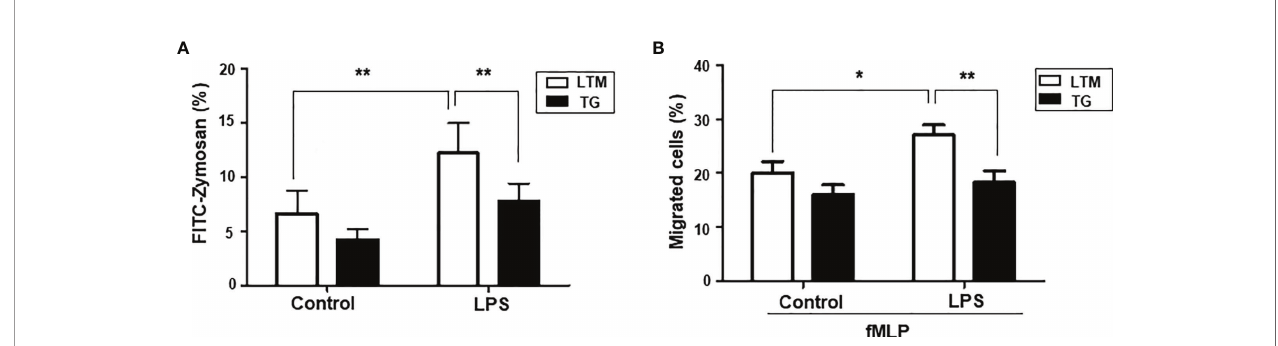
FIGURE 5 | Phagocytic and chemotactic ability of PMs from LTM and p190RhoGEF TG mice. PMs from LTM and TG mice were cultured in media with or without LPS (100 ng/ml) overnight. These PMs were used for the assay. (A) PMs (2.5 x 10 5 ) were incubated with FITC-conjugated zymosan (20 m g/ml) at 37 ° C for 30 minutes. The PM population made fl uorescent by zymosan internalization was detected using fl ow cytometry. The data are the mean ± SEM of fi ve independent experiments. Statistical signi fi cance was analyzed by one-way ANOVA with Tukey ’ s multiple comparison tests. Signi fi cant comparisons are noted as ** p < 0.01. (B) PMs (2.5 x 10 5 ) were added to the upper wells of a Transwell plate that contained the chemoattractant fMLP (1 mM) in the lower chambers. The cells that migrated to the lower chamber were counted after the plate was incubated at 37 ° C for 2 hours. The data are presented as the percentage of the total cells that migrated. The data shown are the mean ± SEM of three independent experiments with duplicate sample settings. Statistical signi fi cance was analyzed by one-way ANOVA with Tukey ’ s multiple comparison tests. Signi fi cant comparisons are noted as * p < 0.05, ** p < 0.01.